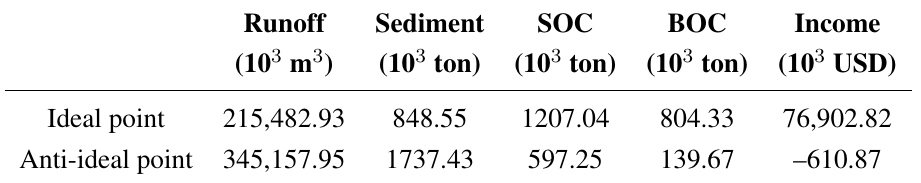
Table 1. Regional ideal and anti-ideal points used in the compromise programming (CP)-derived